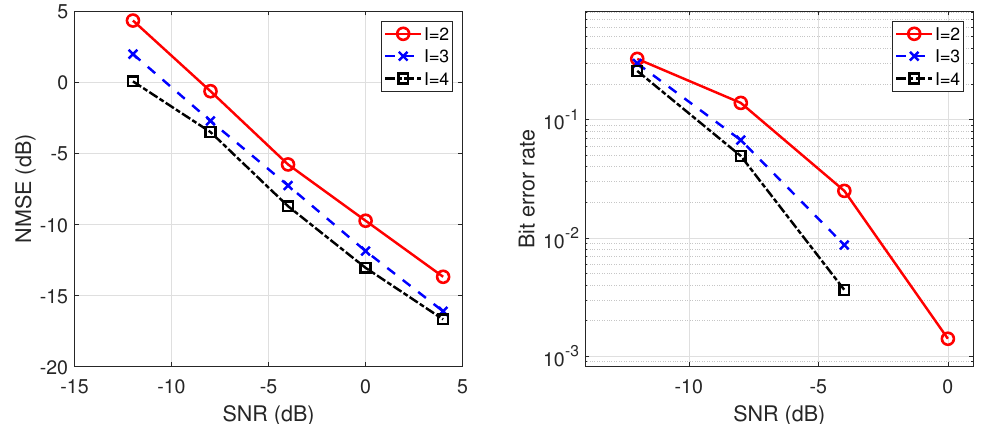
Figure 4. NMSE of estimated spreading waveform and BER of information sequence ( L = 63, G = 30, R = 3, M = 100).